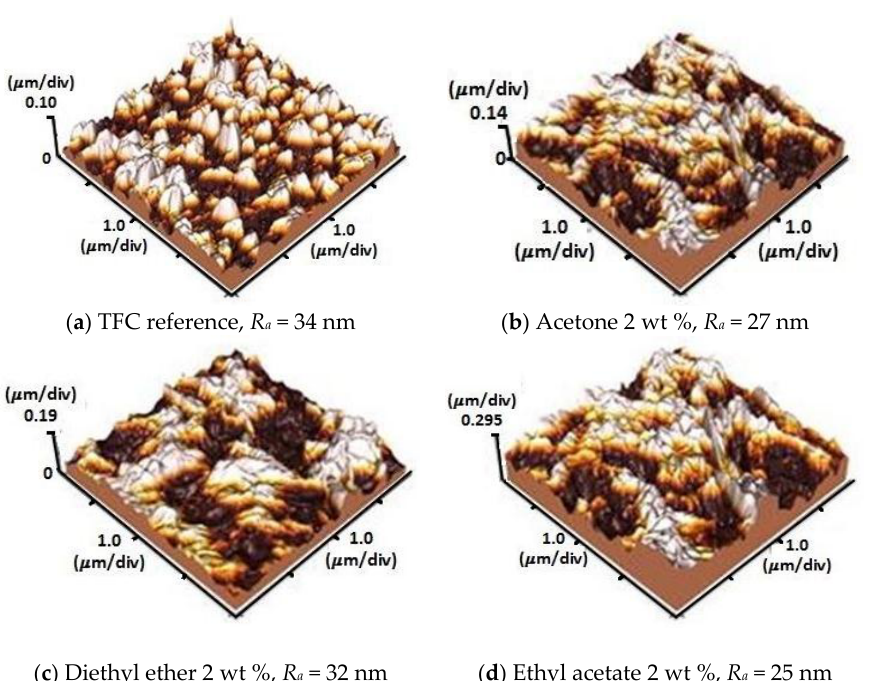
Figure 3. AFM images of formulated membranes with 2 wt % of co-solvents added ( a ) no co-solvent added; ( b ) acetone; ( c ) diethyl ether; and ( d ) ethyl acetate.